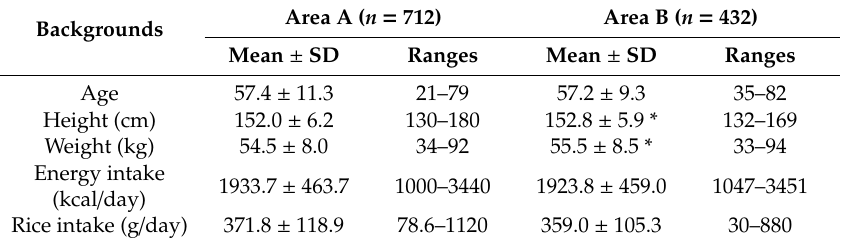
Table 11. Backgrounds of female farmers who underwent health examinations in areas A and B.